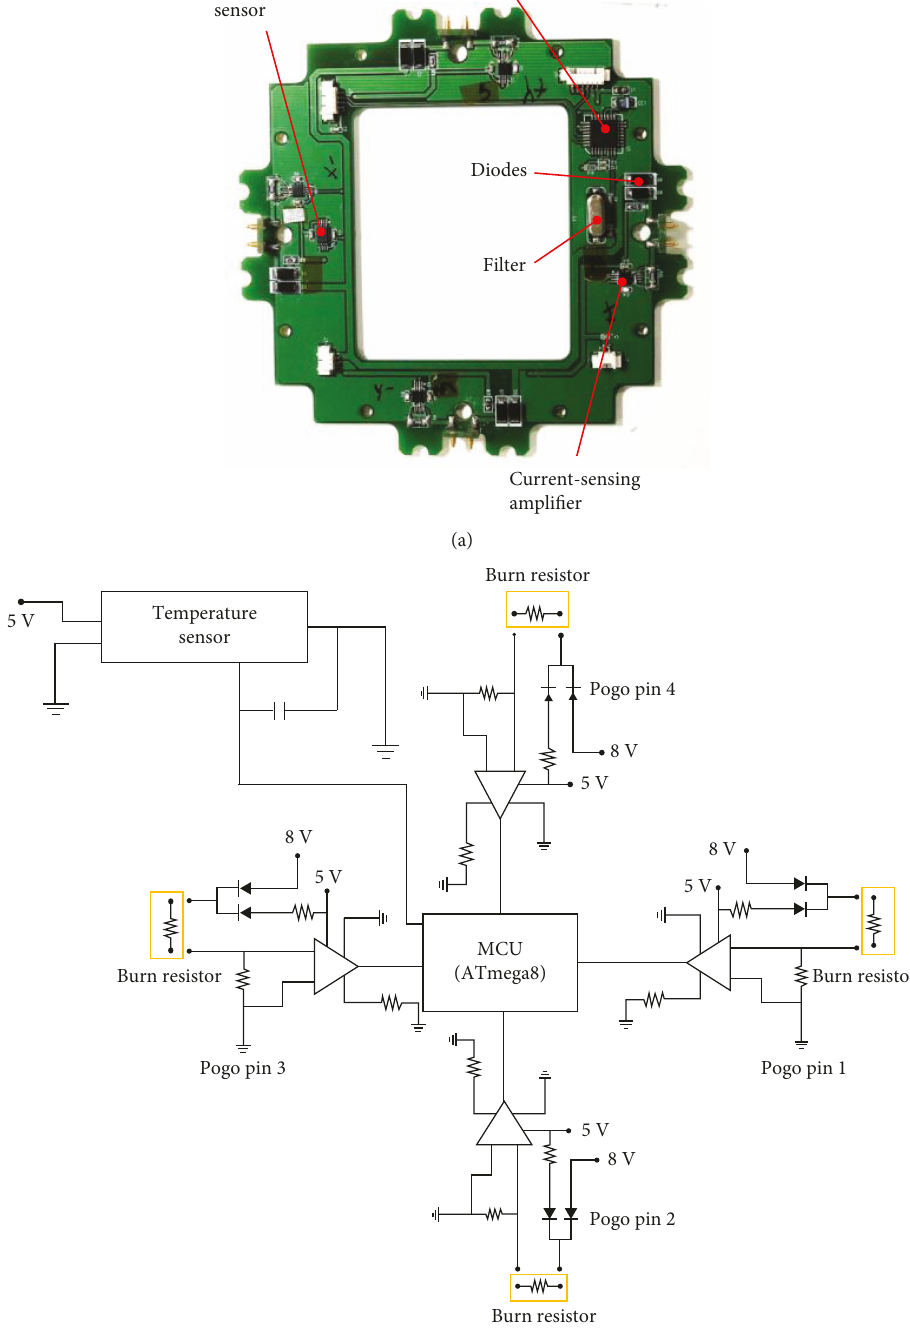
Figure 3: Con fi gurations of primary PCB: (a) mechanical con fi guration and (b) electrical con fi